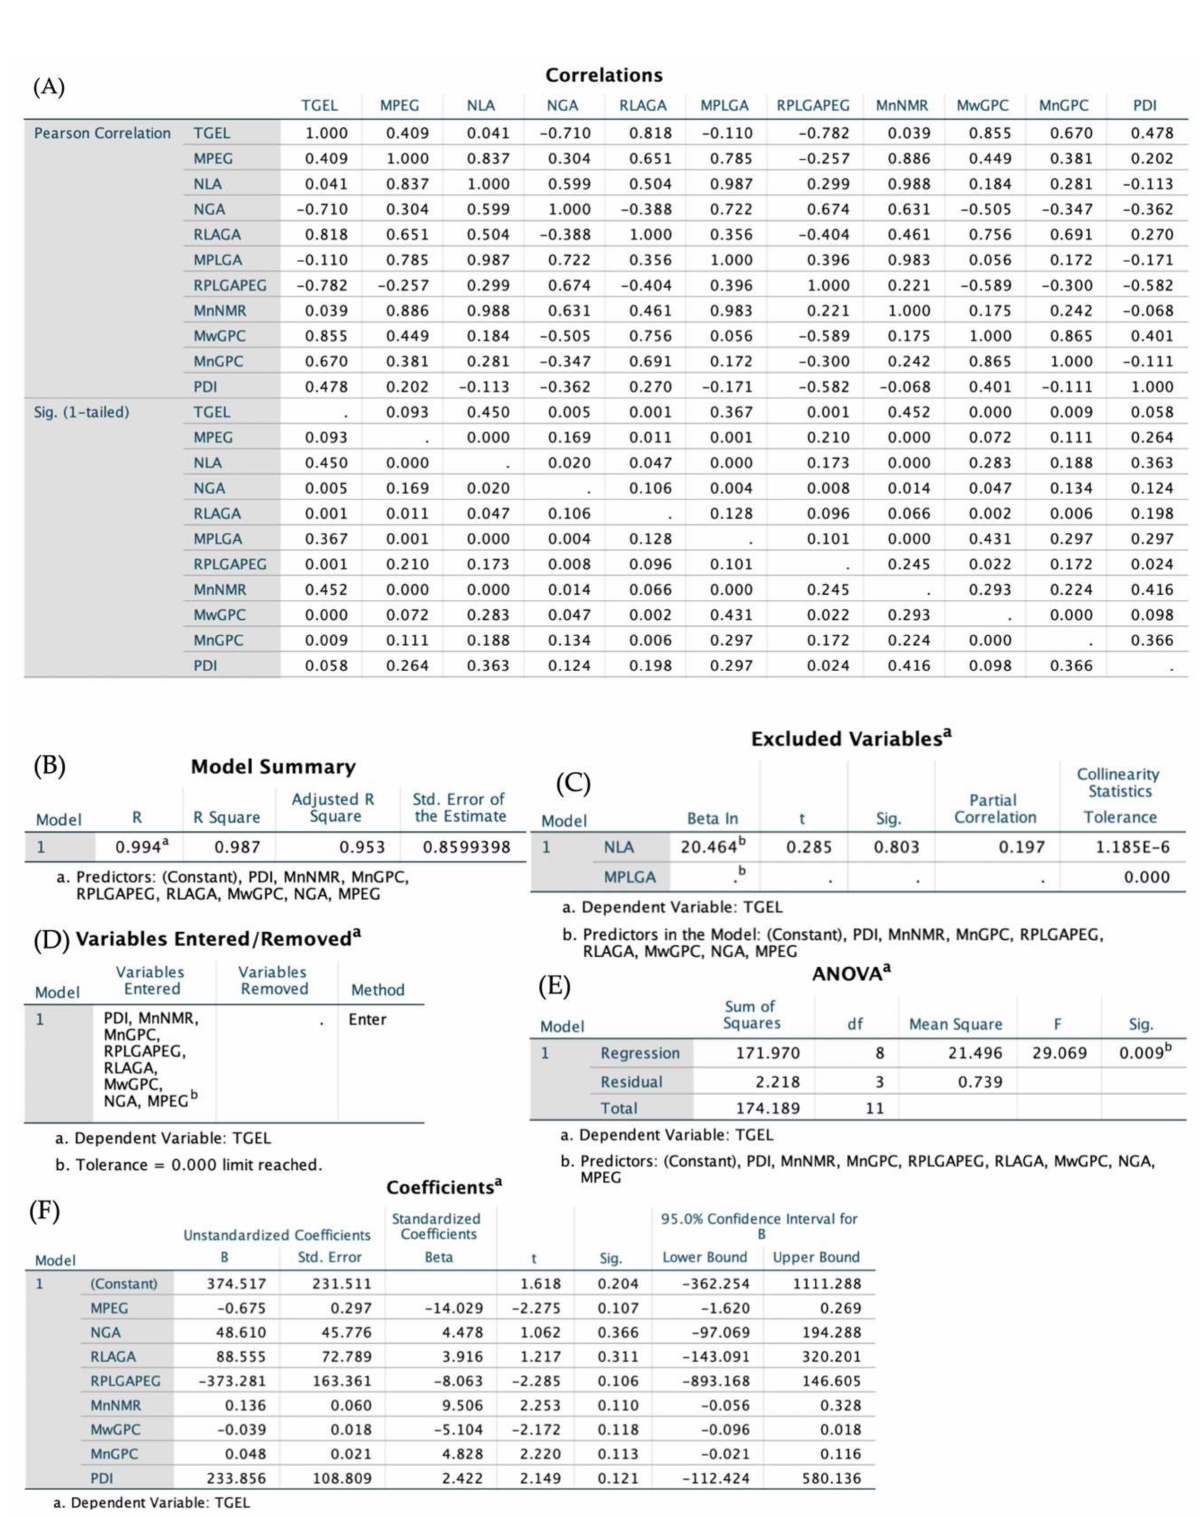
Figure 5. Linear Regression analysis of T gel by M PEG , M PLGA , N LA , N GA , R LA/GA , R PLGA/PEG , M n NMR, M w GPC, M n GPC and PDI. ( A ) Pearson Correlation and significance between variables. ( B ) Goodness of fit of the Linear Regression Model. ( C ) Variables excluded in the linear fitting process. ( D ) Variables that was selected in Enter mode. ( E ) ANOVA test for linear regression. ( F ) Coefficients and the Z − score standardized coefficients of the